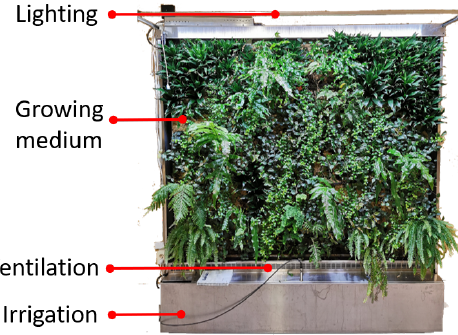
Figure 3. An example of a vertical plant wall system, which integrates lighting, ventilation, irrigation systems, and a growing medium to support green plants to grow on the surface.